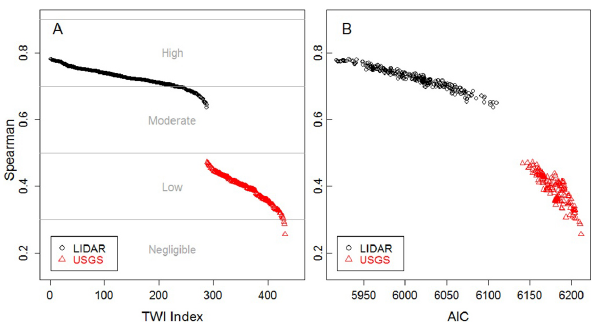
Figure 13. (A) Spearman correlation coefficients vs. TWI. (B) Spearman correlation coefficients vs. AIC values from all 432 mixed effect